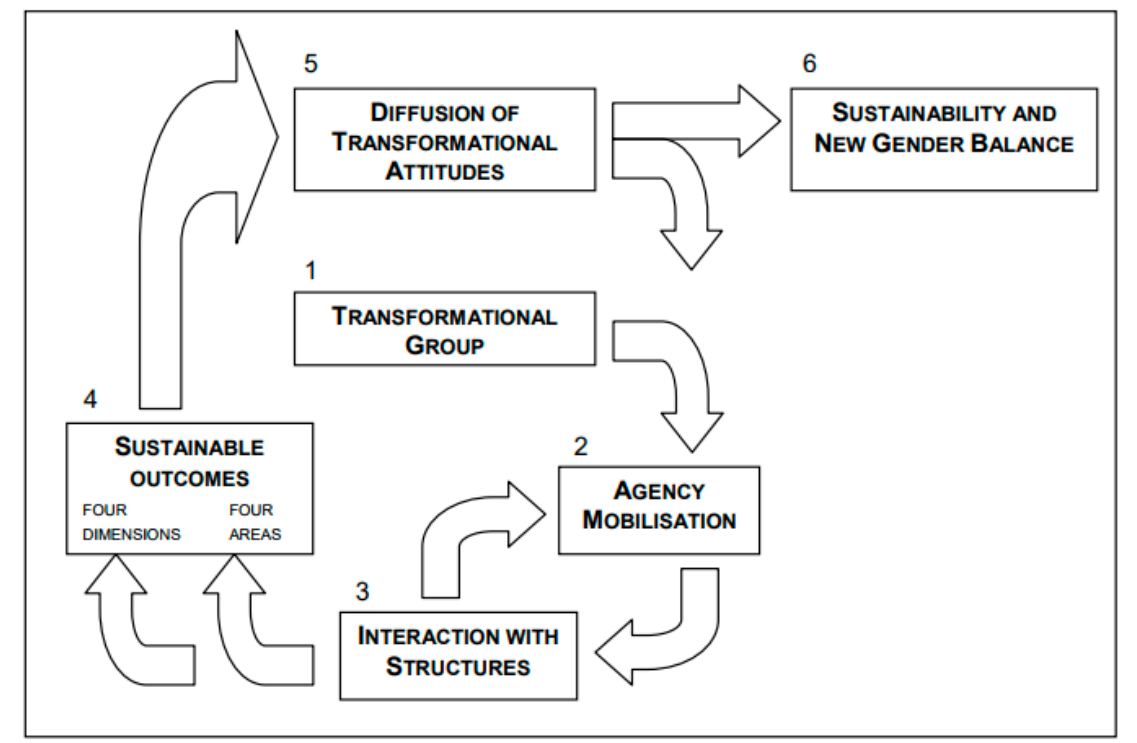
Figure 3. The chain of institutional change for gender equality in research organisations (Cacace et al. 2016).